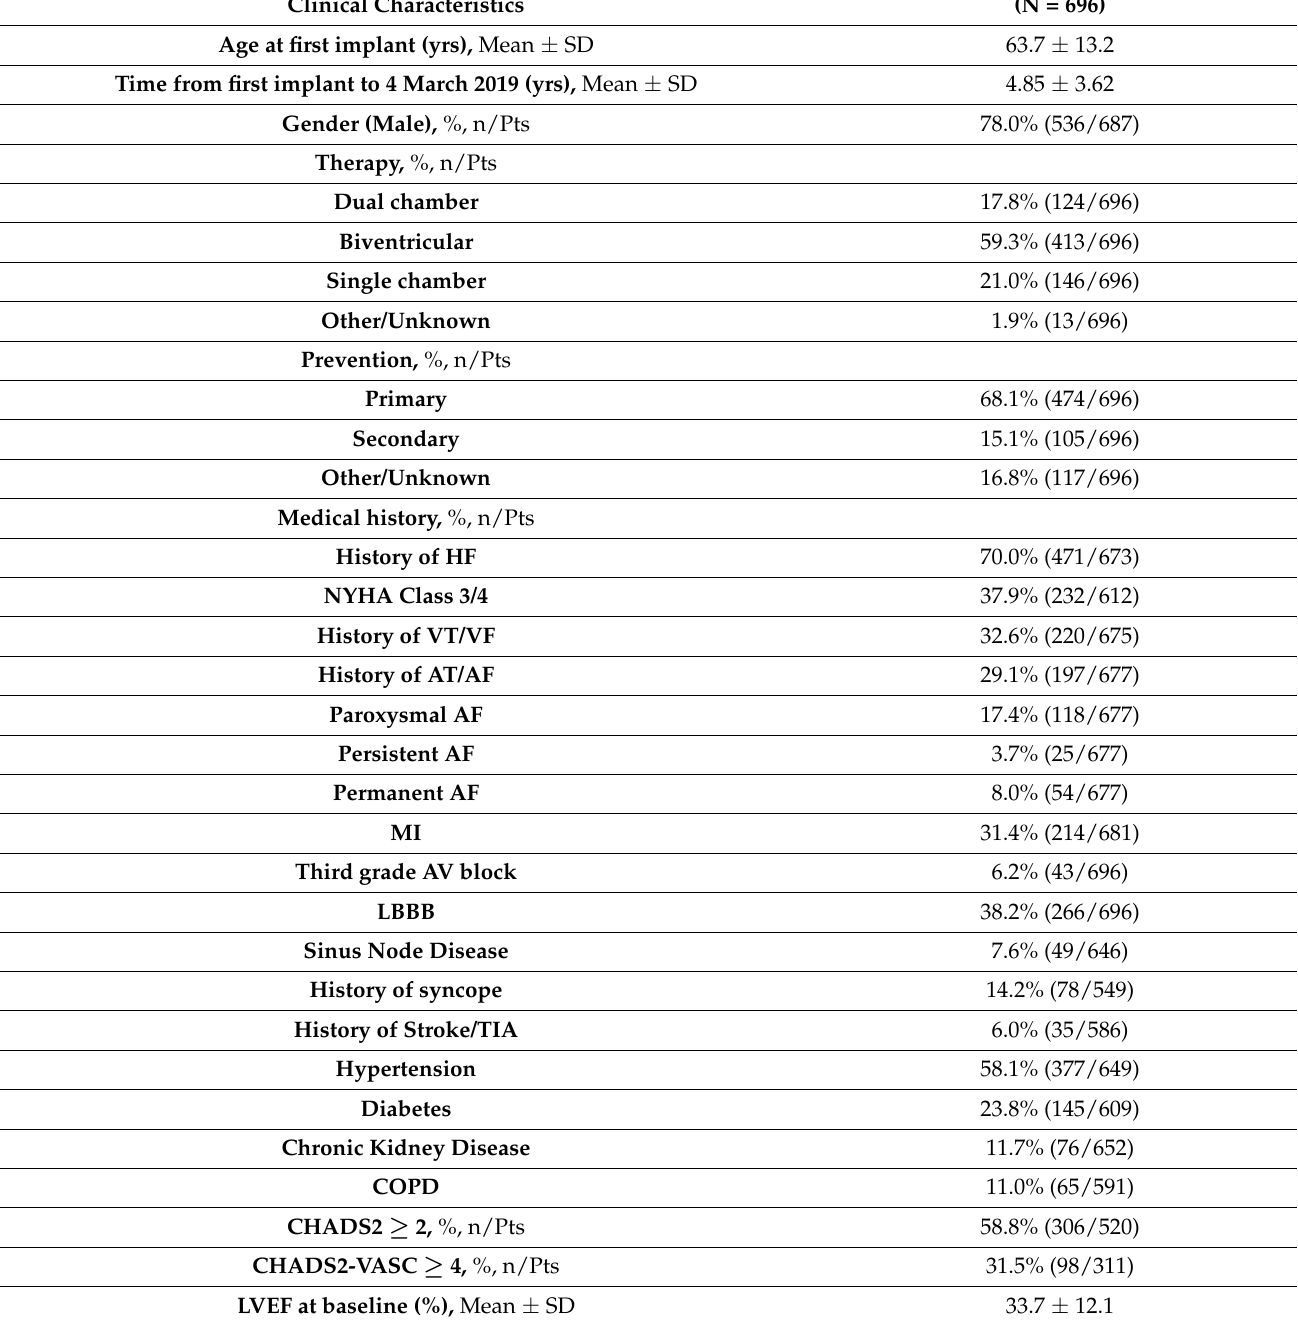
Table 1. Characteristics of the enrolled